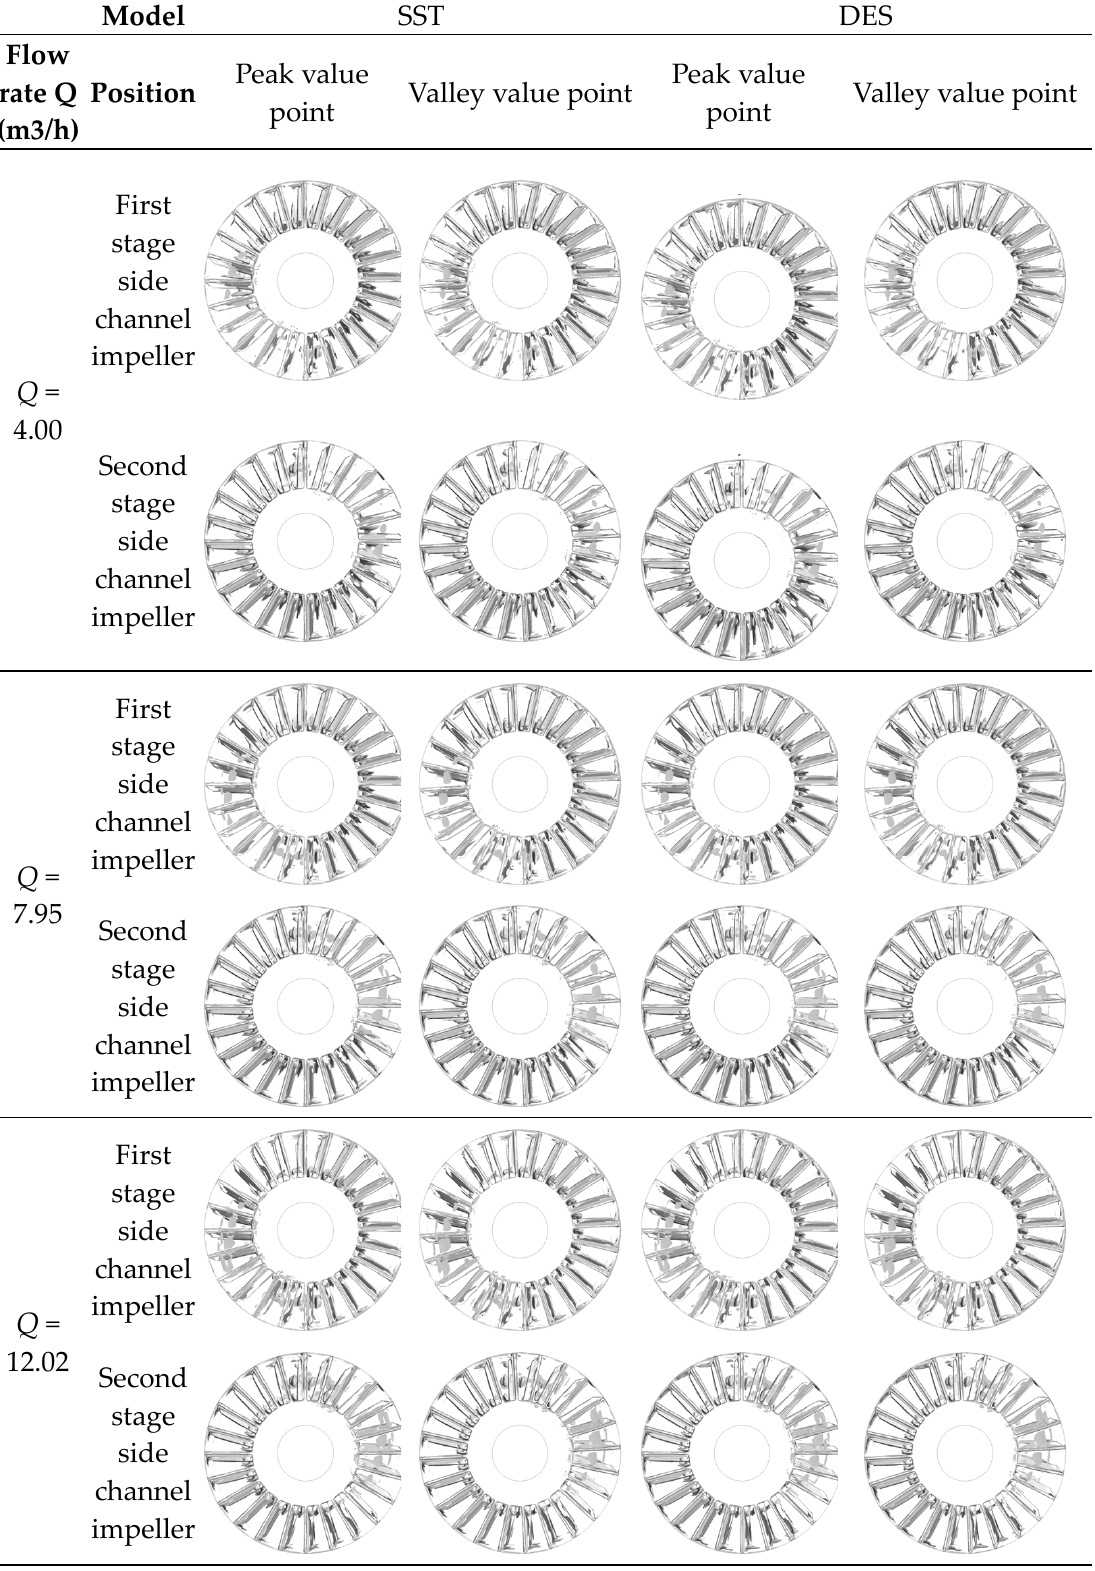
Figure 11. Distribution of vortex core area of side channel impeller with the SST and DES models at the peak and valley points of the head (instantaneous).